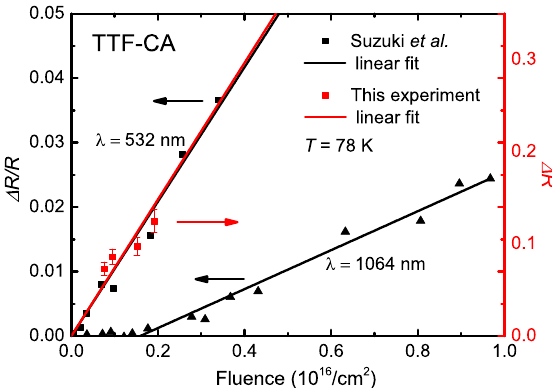
Figure 26. Comparison of the results from our study recorded at ν = 1390 cm − 1 and T = 78 K with an excitation energy of 2.33 eV ( λ = 532 nm) with the variation of the reflectivity at 24,200 cm − 1 from Ref. [85] recorded at 3 µ s after the photo perturbation was also detected at T = 78 K for two different excitation energies ( λ = 532 nm and 1064